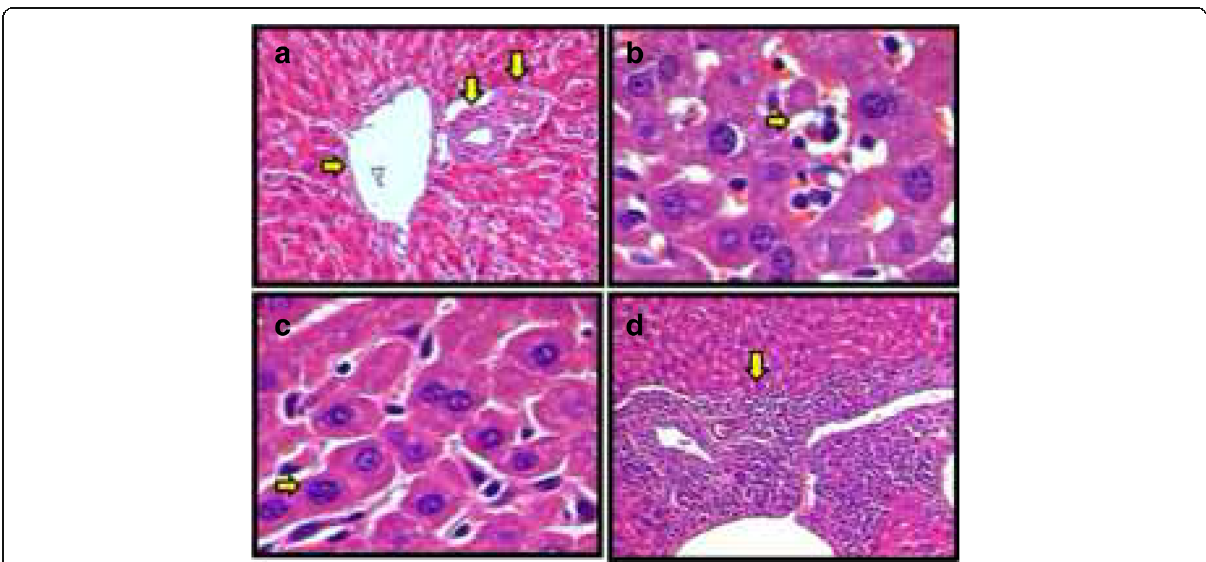
Fig. 4 Histopathology of the livers from the different experimental groups: ( a ) Mesosphaerum sidifolium essential oil (EOM) (50 mg/kg) - Portal space with a vasculobiliar triad; ( b ) EOM (150 mg/kg) - Anaplastic tumor cells, bordered by necrosis of the hepatic tissue; ( c ) EOM (100 mg/kg) - Reactive hyperplasia of Kuppfer cells; ( d ) 5-FU (25 mg/kg) - Lymphocytes at the moderate level compromising the portal space. Hematoxylin- eosin (100 or 400